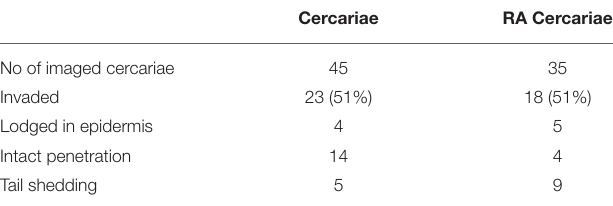
TABLE 1 | Skin invasion by